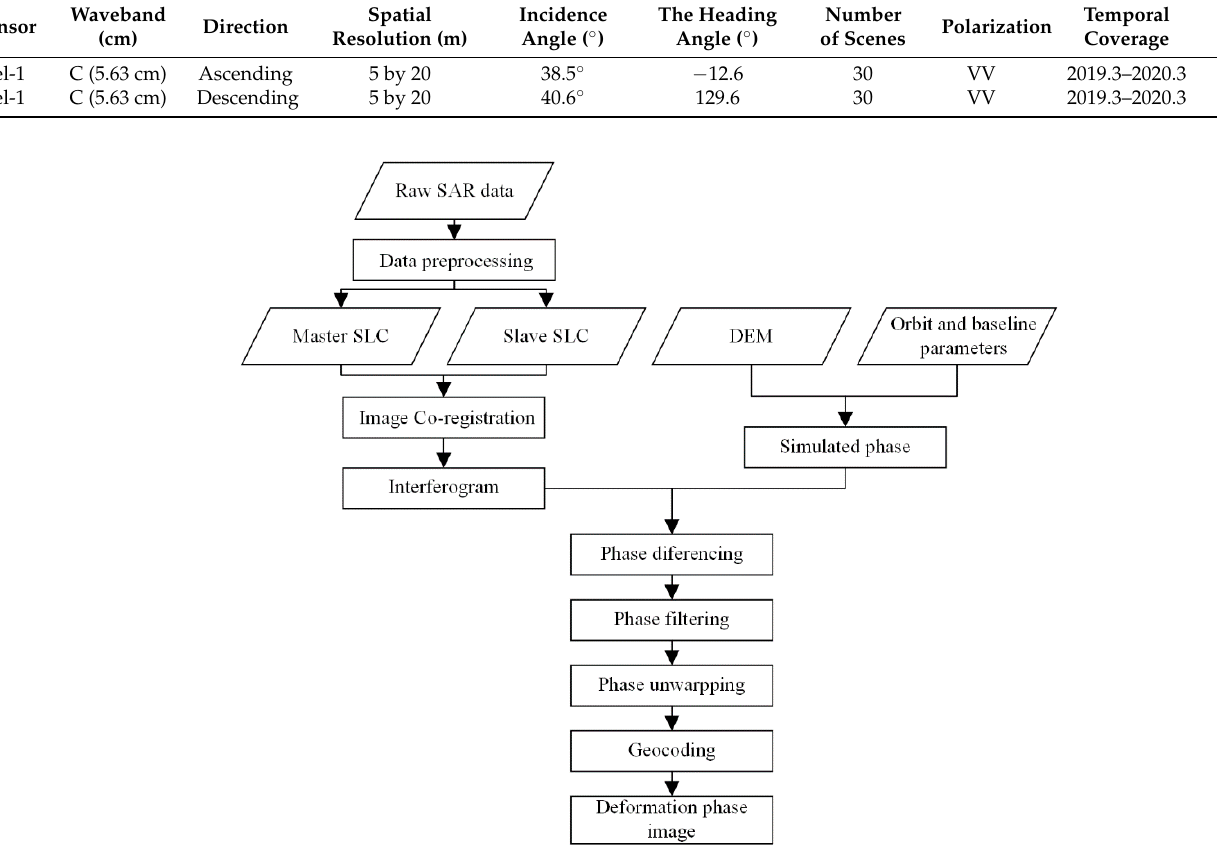
Figure 2. D-InSAR process flow.